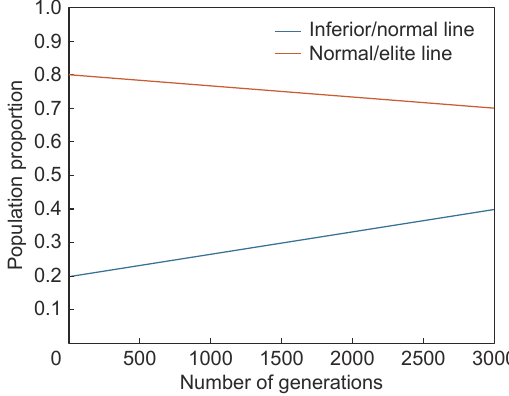
Fig. 1 Change process of parameter k